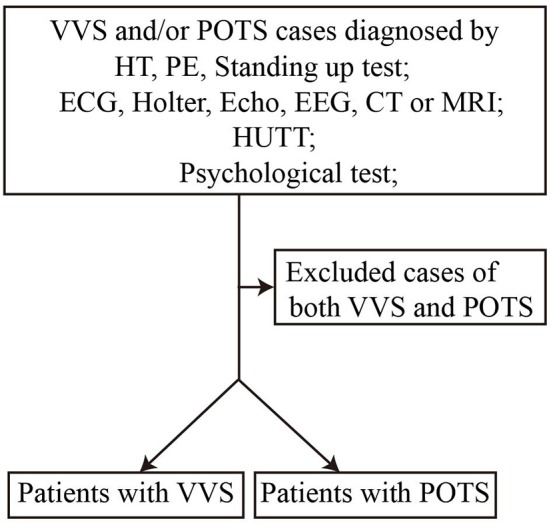
Flow chart of enrollment of study population. VVS, vasovagal syncope; POTS, postural tachycardia syndrome; HT, history taking; PE, physical examination; ECG, electrocardiogram; Echo, echocardiogram; EEG, electroencephalogram; CT, computed tomography; MRI, magnetic resonance imaging; HUTT, head-up tilt test.